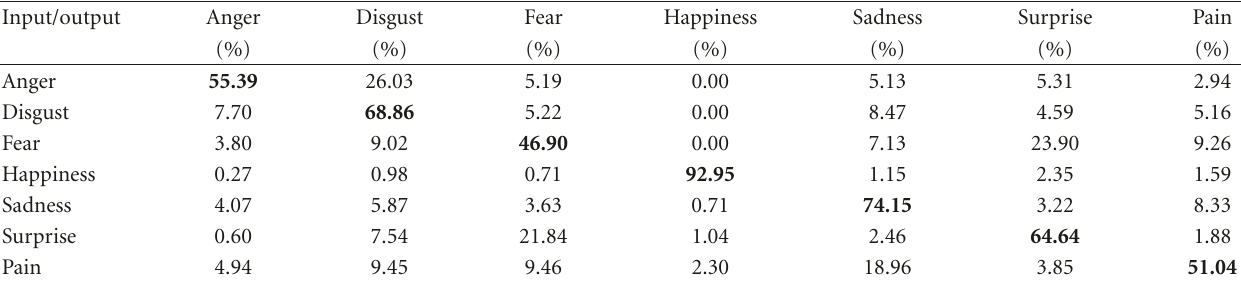
Table 6: Confidence confusion matrix for the human observers using 2D video